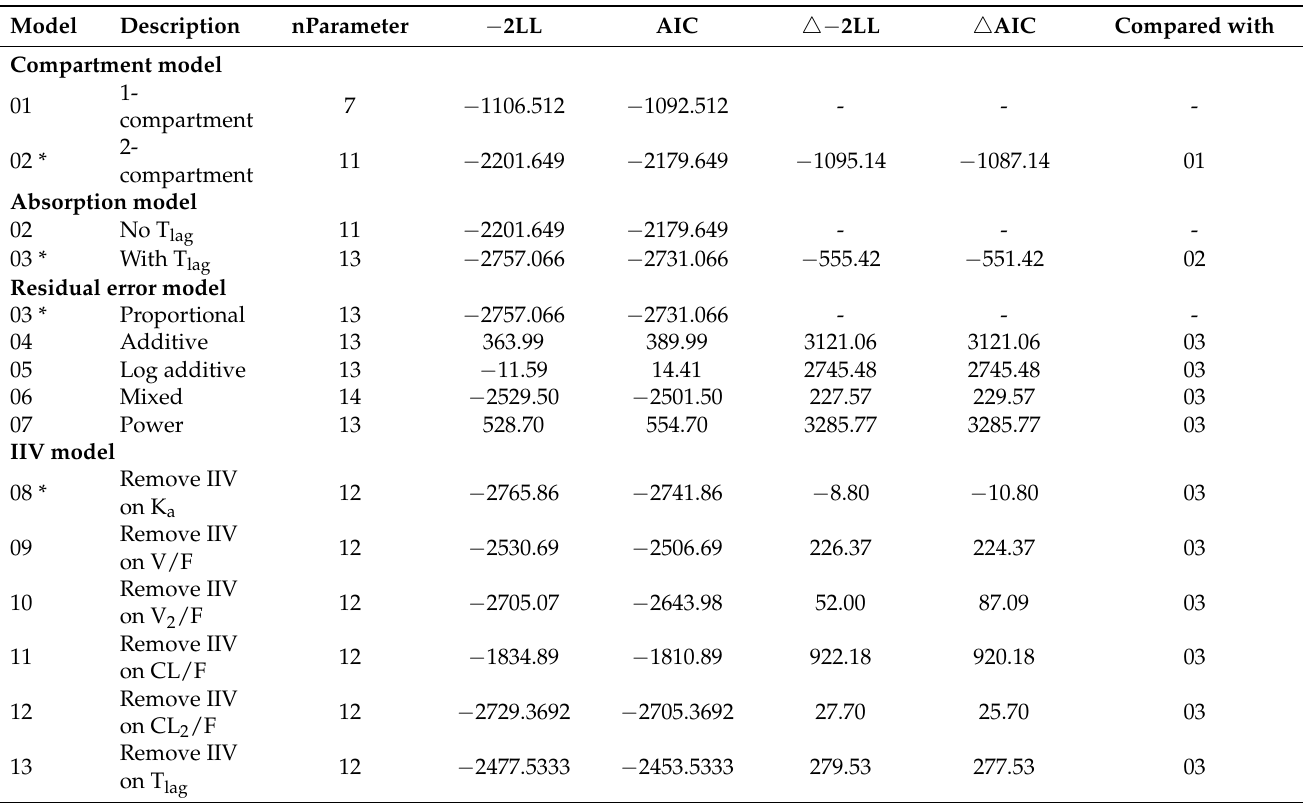
Table 2. Steps used for building a basic structural model of